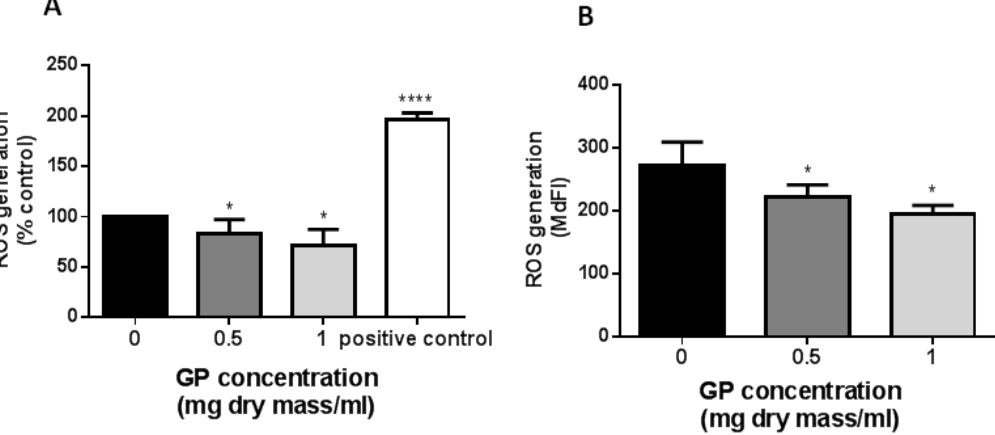
Figure 5. Effect of G. parviflora extract (GP) on endothelial ROS production. HUVECs EA.hy926 line were treated with GP extract or vehicle control for 24 h. ( A ) ROS generation were measured after H2DCFDA labeling. The data were derived from three independent experiments and are expressed as a percentage of control. The positive control is hydrogen peroxide (100 µM). Asterisks represent a significant difference compared to the control cells. ( B ) ROS generation was measured by flow cytometry after labeling with DHR. The data were derived from five independent experiments and are expressed as mean ± SD. Asterisks represent a significant difference when compared to control cells (* p < 0.5, **** p < 0.0001).